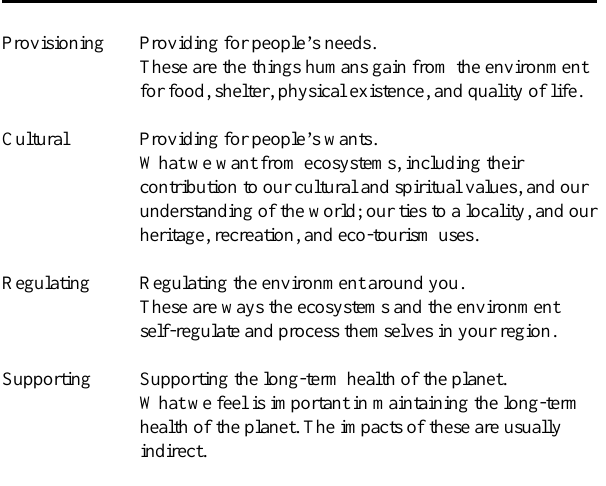
Table 2 . Plain English definitions of ecosystem service